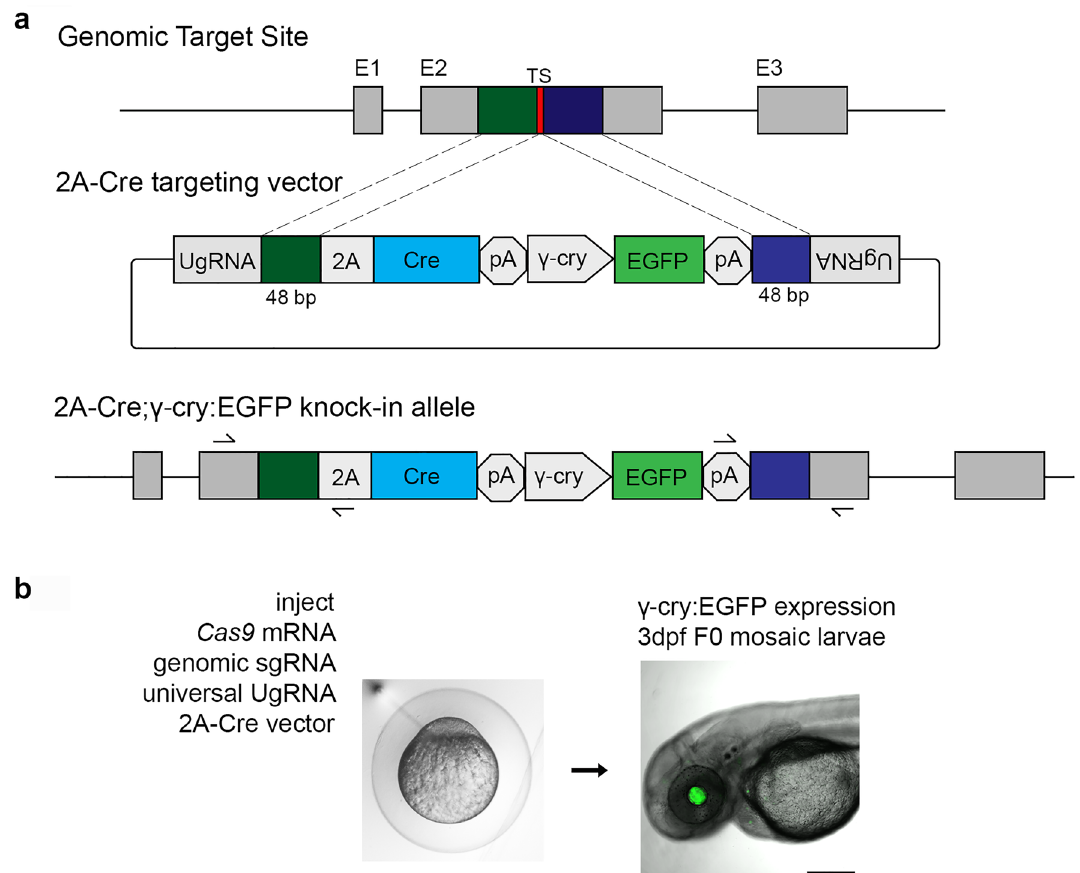
Figure 1. CRISPR/Cas9 short homology directed targeted integration strategy for efficient recovery of Cre knock-in alleles. ( a ) Schematic of the genomic target site, Cre donor vector, and final knock in allele. A CRISPR sgRNA (red) was chosen in the coding sequence. 48 bp upstream (dark green) and 48 bp downstream (dark blue) of the cut site are included in the donor vector as homology arms. The donor vector has UgRNA sequences flanking the homology arms for in vivo liberation of the knock in cassette. The knock-in cassette contains an in frame 2A-Cre for expression of Cre recombinase, and a secondary marker driving γ-cry:EGFP expression in the lens. Arrows indicate PCR primers for 5 ′ and 3 ′ genome/vector junction analysis. ( b ) 1 cell stage zebrafish embryos are injected with Cas9 mRNA (300 pg), genomic sgRNA (25 pg), UgRNA (25 pg), and 2A-Cre targeting vector (10 pg). At 3 days post fertilization, embryos expressing EGFP in the lens are selected and raised to adulthood. TS genomic sgRNA target site, UgRNA universal short guide RNA target site, γ- cry gamma crystallin promoter, EGFP green fluorescent protein, pA transcription termination and polyadenylation sequence.